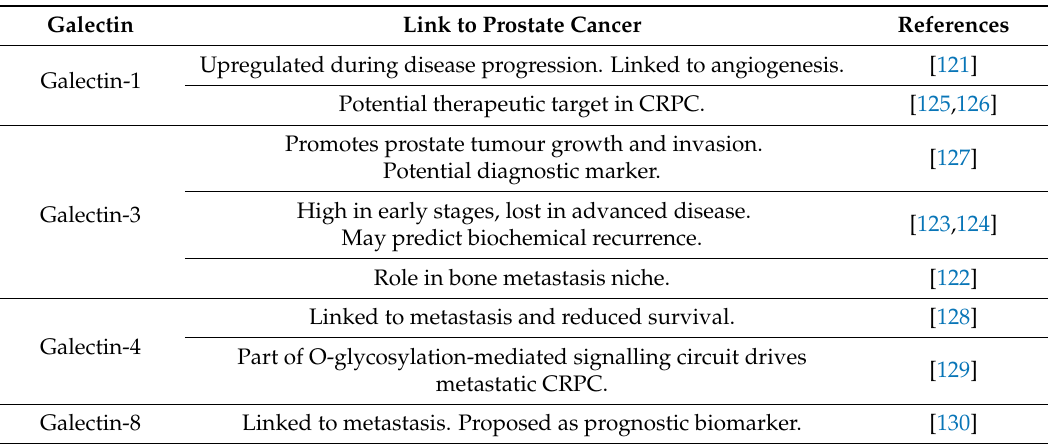
Table 3. Galectins with roles in prostate